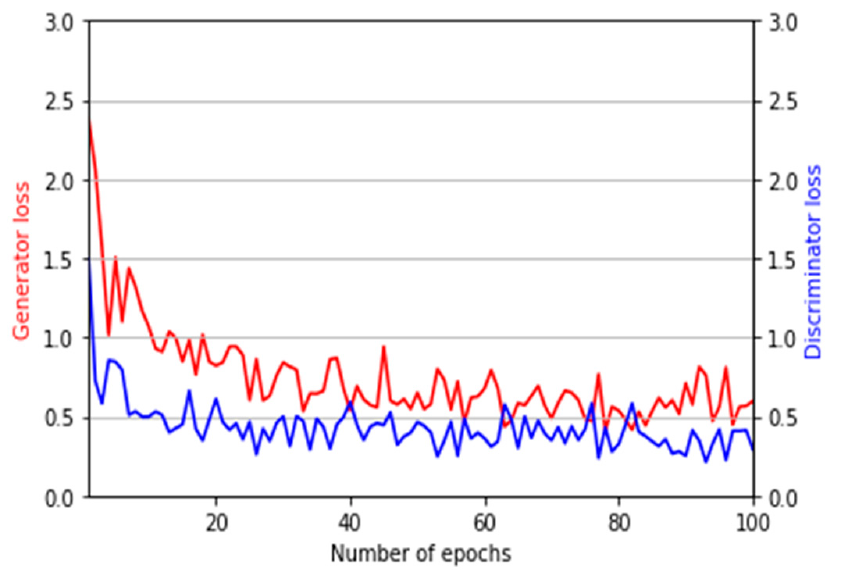
Figure 6. Graphs of training loss and accuracy by CycleGAN.